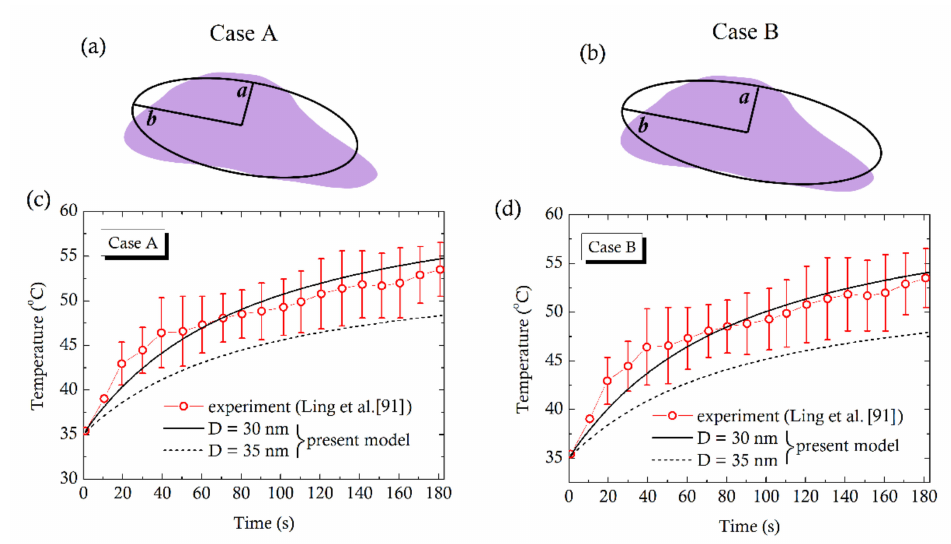
Figure 13. Two cases approximating the tumor shape from a histological cross-section by Ling et al. [91], with a prolate spheroid. Note that the tumor histological cross-section has been redrawn from the original: ( a ) prolate spheroid shape, case A with AR ≈ 2.5, on top of the redrawn tumor and ( b ) prolate spheroid shape, case B with AR ≈ 2.82, on top of the redrawn tumor. Compar- ison of the present model assuming two nanoparticle size values, with experimental temperature measurements at the tumor surface for ( c ) Case A and ( d ) Case